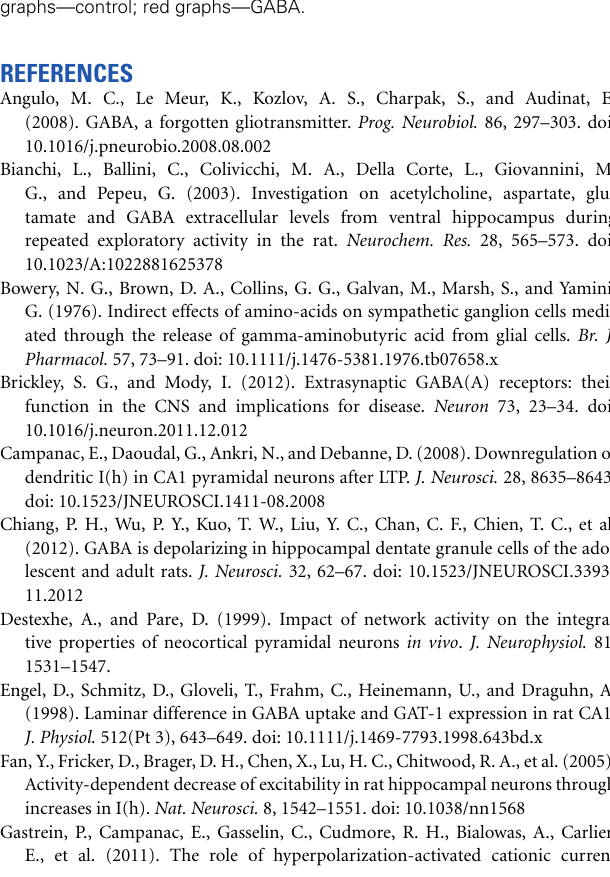
Supplementary Figure 1 | Effect of exogenous GABA on the timecourse of EPSP triggered by stimulation of Schaffer collaterals without blocking GABA B receptors. EPSP measurements obtained in 4 cells: 20–80% rise time ( top row ) and decay time constant ( bottom row ).